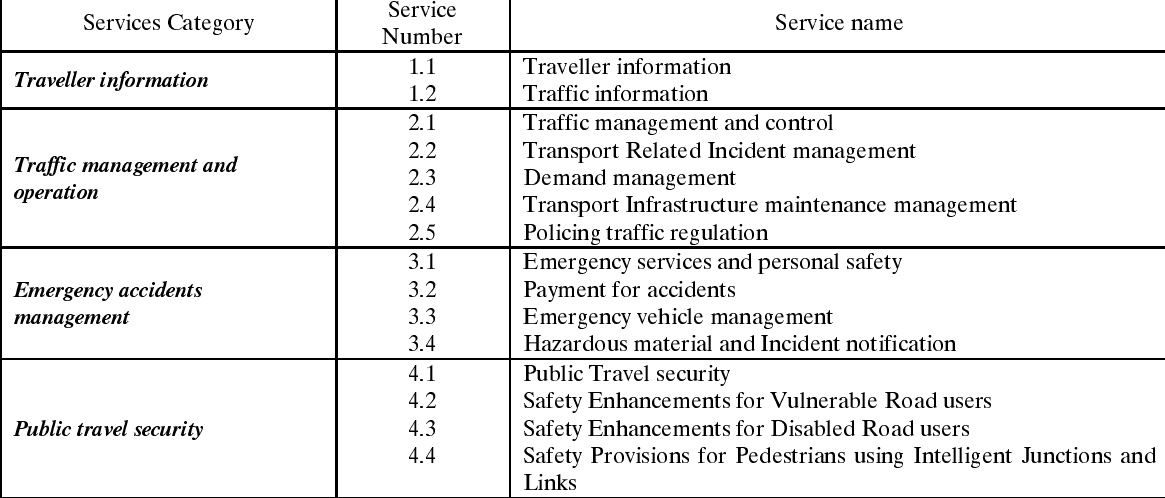
Table 3. ITS services (according to standard ISO/TR 14813-1:1999) in Lithuania Services